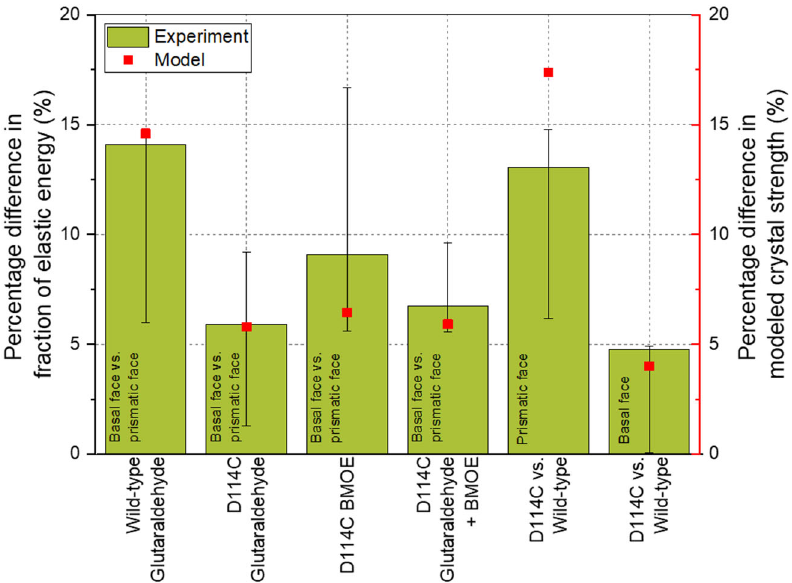
Figure 9. Comparison of the experimental and the modeled results of wild-type HheG crystals and the mutant D114C.